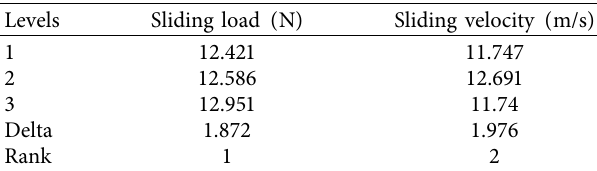
Table 7: An optimum response for S/N ratios (COF–AAZrB hybridized